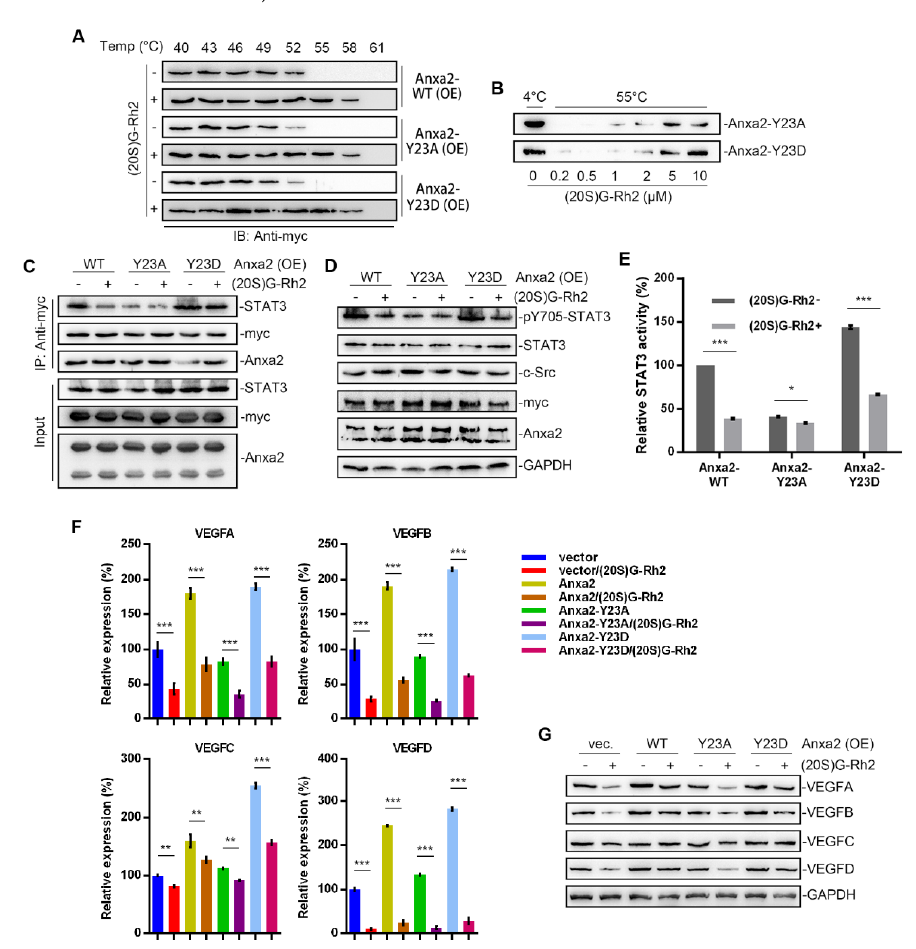
Figure 5. (20S)G-Rh2 interacted with Anxa2-Y23D mutant and inhibited related STAT3 activation. Myc-tagged wild-type, Y23A mutant, and Y23D mutant of Anxa2 was over-expressed in HepG2 cells. ( A ) Cellular thermal shift assay was performed with (20S)G-Rh2 at indicated temperature gradient in Anxa2-over-expressed HepG2 cells, and determined by immuno-blotting. ( B ) Thermal shift assay was performed with purified Anxa2 mutant and (20S)G-Rh2 gradient at 55 °C, and determined by immuno-blotting. ( C – E ) HepG2 cells with Anxa2 over-expression were treated with (20S)G-Rh2. Immuno-precipitation with anti-Anxa2 antibody ( C ) and protein level ( D ) were determined by immuno-blotting. STAT3 activation was determined via reporter gene assay ( E ). ( F , G ) Expression of four VEGFs in (20S)G-Rh2-treated HepG2 cell was determined by qRT-PCR ( F ) and immuno-blotting ( G ). Significance analysis was shown as * ( p < 0.05), ** ( p < 0.01) and *** ( p < 0.001).